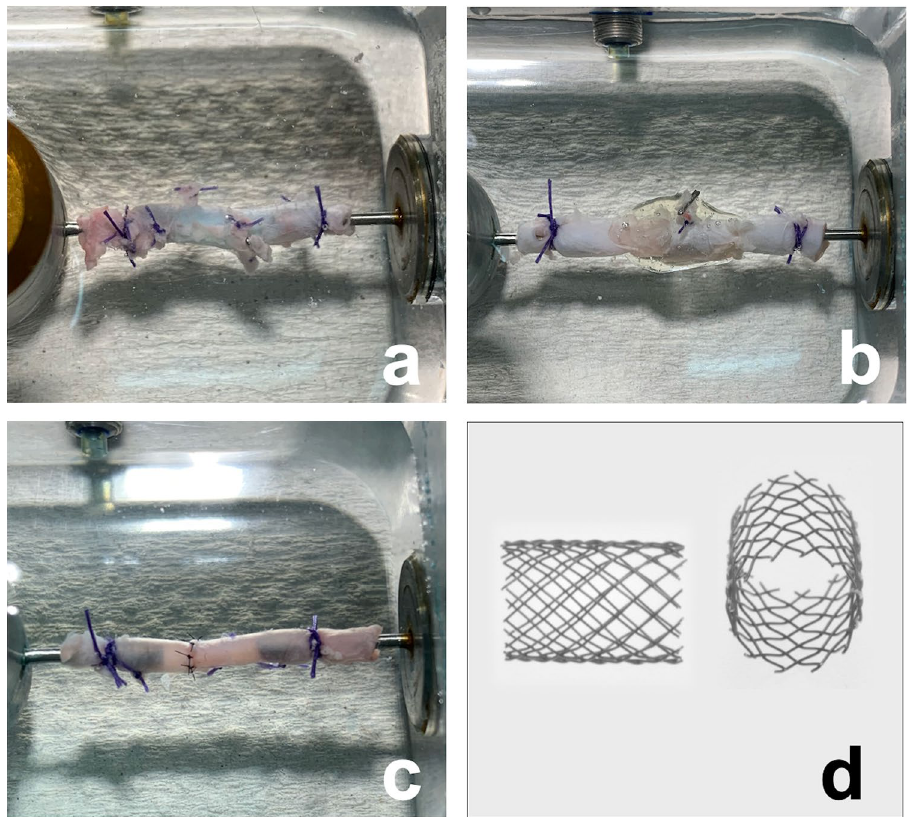
Figure 1. Vessels fixed in pressure apparatus. The native vessels served as control. Side branches were ligated ( a ). The Anastomosis made of VIVO and stent and the transparent nature of the adhesive allows control of the anastomosis region ( b ). Sutured anastomoses are the gold standard in microsurgery ( c ). Enlarged images of the stent design are shown in two perspectives ( d